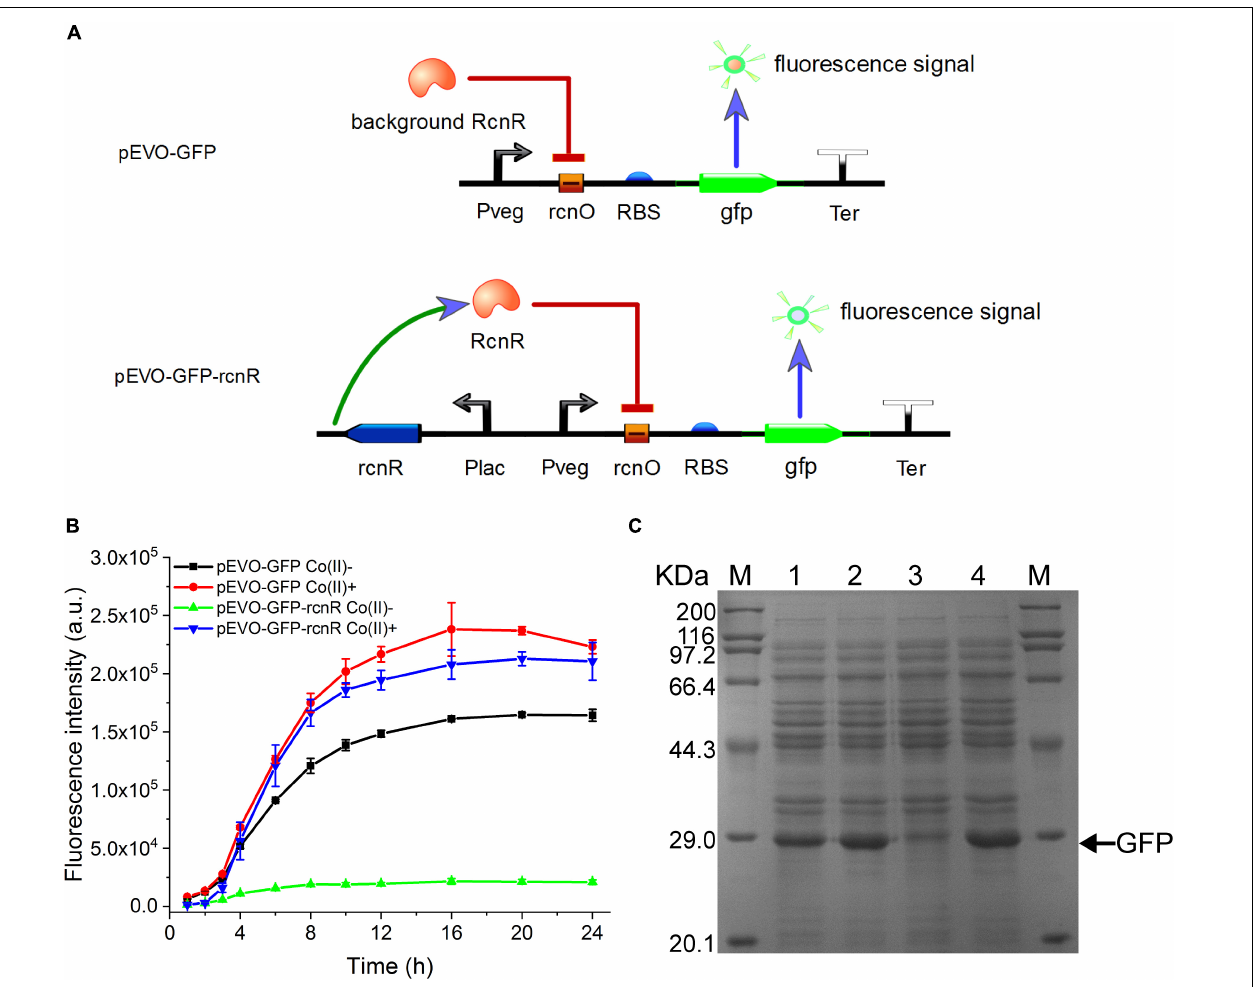
FIGURE 1 | Construction and verification of CIES. (A) Schematic diagram of CIES. (B) GFP expression profile by cells harboring pEVO-GFP and pEVO-GFP- rcnR . Cobalt chloride was added at 2 h after inoculation with 100 µ M of the final concentration. (C) SDS-PAGE analysis of GFP expression by cells harboring pEVO-GFP and pEVO-GFP- rcnR . M: marker. 1–4: pEVO-GFP Co(II)-, pEVO-GFP Co(II)+, pEVO-GFP- rcnR Co(II)-, and pEVO-GFP- rcnR Co(II)+. The band of GFP was indicated by an arrow. All error bars in figures presented root-mean-square deviation of three separate